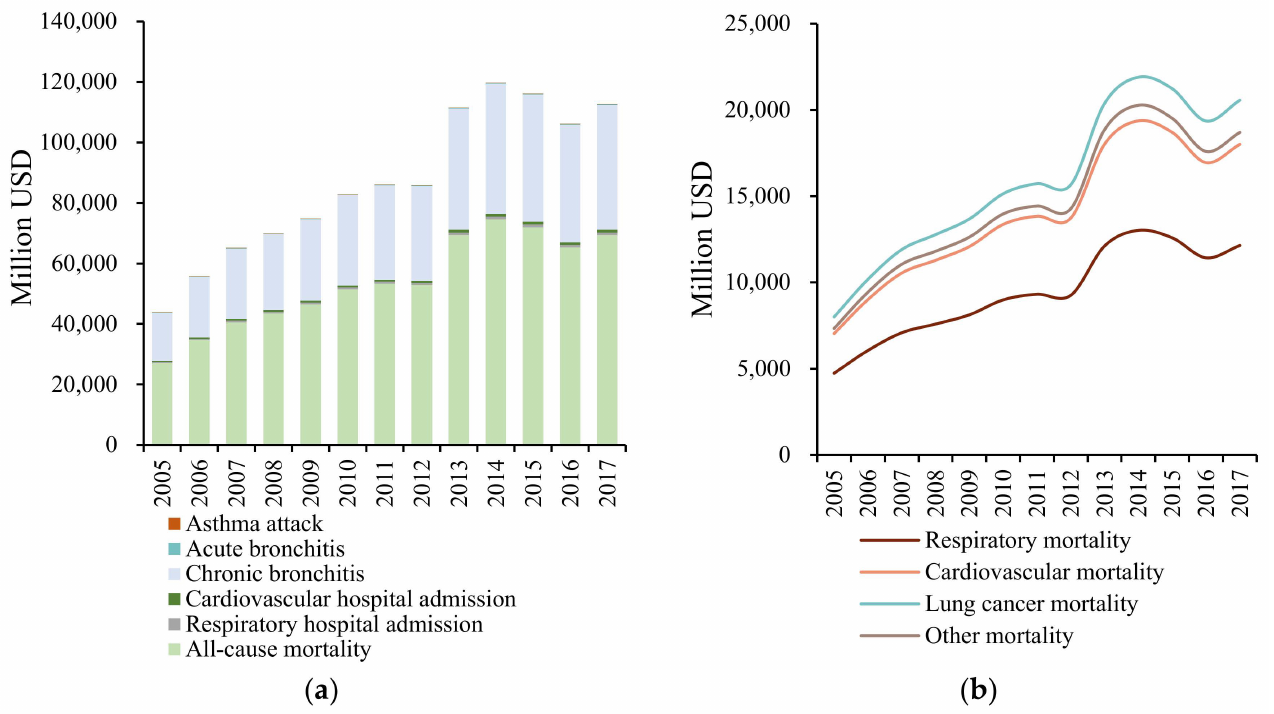
Figure 5. Annual changes in the economic loss by PM 2.5 exposure. ( a ) Estimation of economic loss by PM 2.5 exposure in China during 2005–2017. ( b ) Estimation of the disease-specific mortality economic loss by PM 2.5 exposure in China during